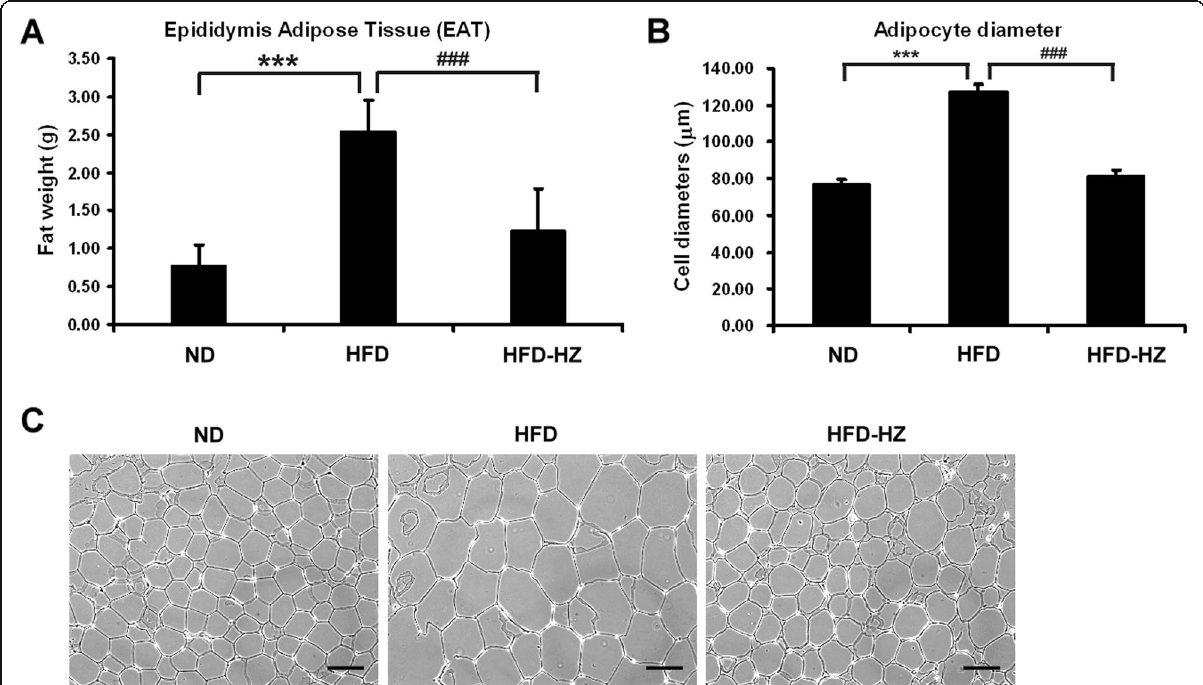
Fig. 4 The effect of HZ extract treatment on epididymis adipose tissue (EAT) in C57BL/6 J mice fed an HFD. a The weight of EAT. b The diameters of adipocytes. c hematoxylin-eosin staining of adipocytes in the EAT of mice. The scale bar is 100 μ M. Data are shown as means ± SEM (n = 10 per group). ND vs. HFD: * p < 0.05; ** p < 0.01; *** p < 0.001. HFD vs. HZ: # p < 0.05; ## p < 0.01; ### p <